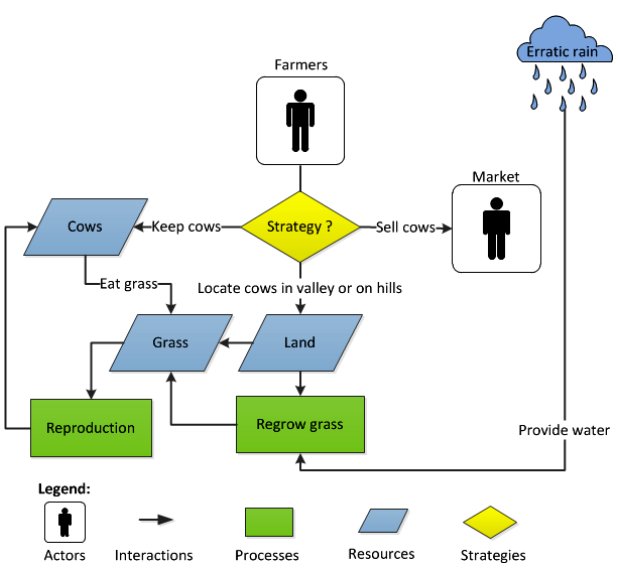
Fig. 3 . Conceptual model of the grazing